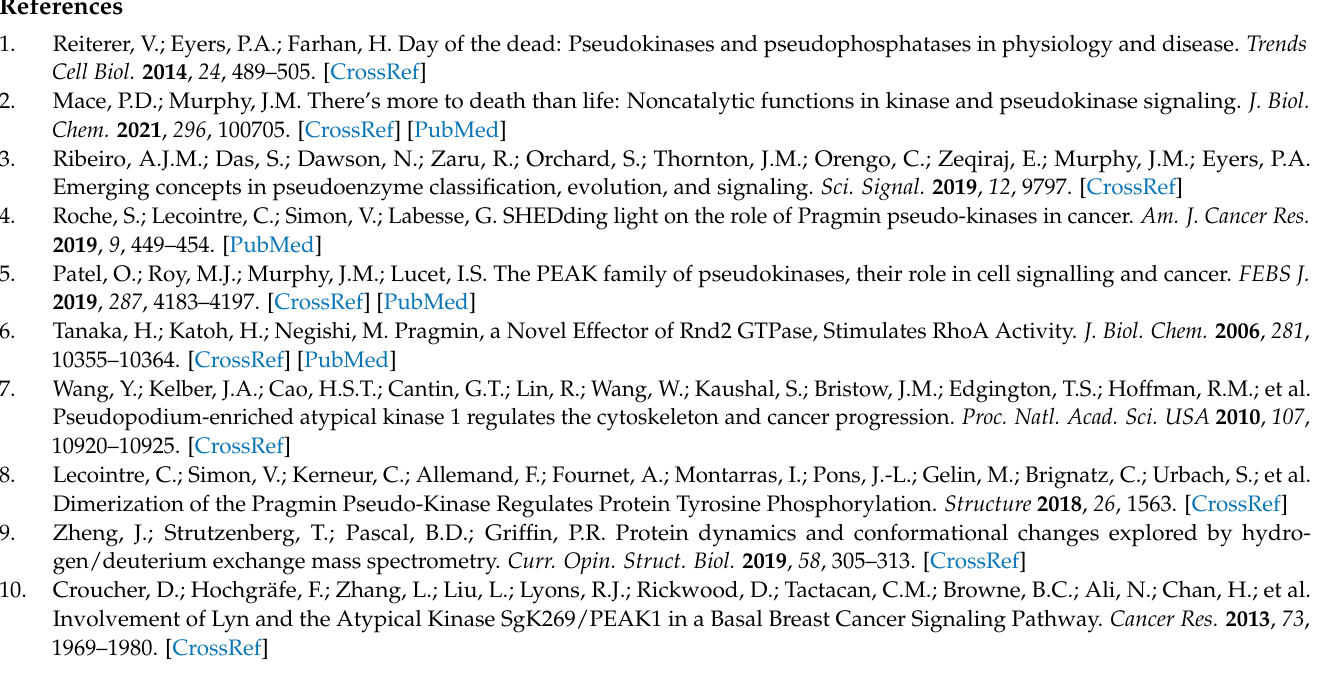
tyrosine signaling, Figure S9: A model on PEAK3 oncogenic signaling, Figure S10: Original Western- blot figures, Table S1: Accession numbers of the PEAK pseudo-kinases used in this study, Table S2: Characteristics of AML patient samples, and Table S3: Main hits recovered from the PEAK3 interactomic analyses in U2OS, HeLa and THP1